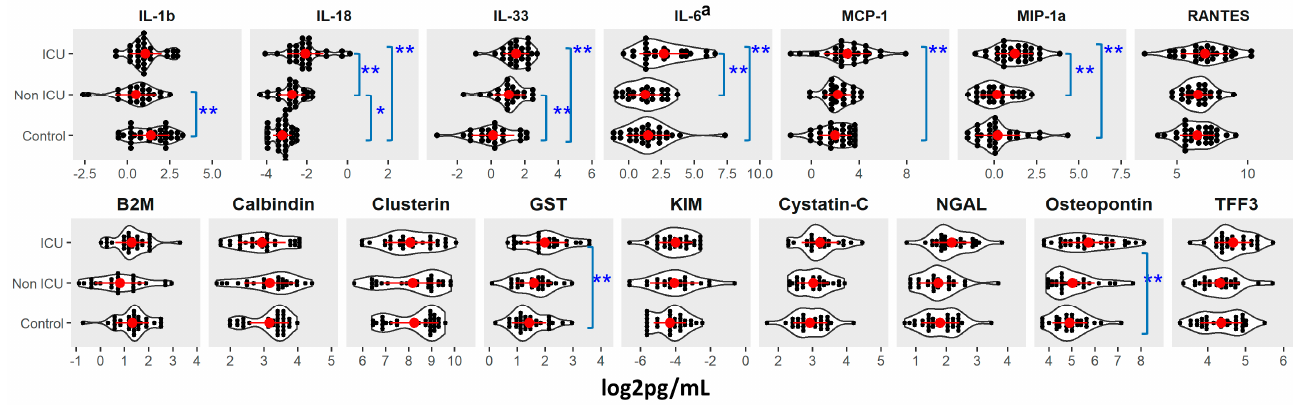
Figure 1. Cytokine and Renal toxicity marker levels by COVID-19 status at sample collection. *: adjusted p -value (FDR) ≤ 0.1; **: adjusted p -value (FDR) ≤ 0.05. a: patients on cytokine inhibitor were excluded for analysis. Details were provided in Table